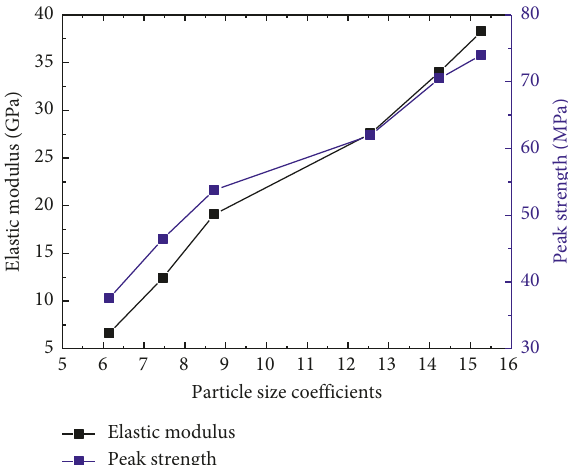
Figure 18: Relationship among particle size coefficient and elastic modulus as well as peak strength.